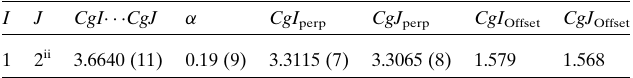
Table 3 (cid:3) – (cid:3) interaction (A˚ , (cid:4) ). Cg 1 is the centroid of the O1/C1/N1/C5/C4 ring and Cg 2 is the centroid of the C4–C9 ring. CgI (cid:2)(cid:2)(cid:2) CgJ is the distance between ring centroids. (cid:5) is the dihedral angle between the planes of the rings I and J. CgI perp and CgJ perp are the perpendicular distances of CgI from ring J and of CgJ from ring I , respectively. CgI Offset and CgJ Offset are the distances between CgI and the perpendicular projection of CgJ on ring I , and between CgJ and the perpendicular projection of CgI on ring J ,